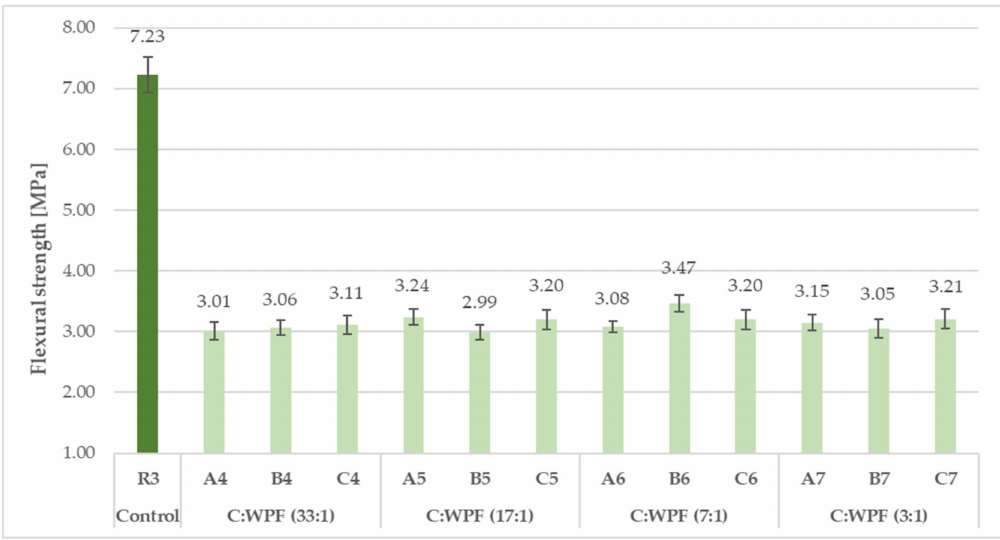
Figure 18. Flexural strength of fiber-cement mortars with different C/WPF ratios (set